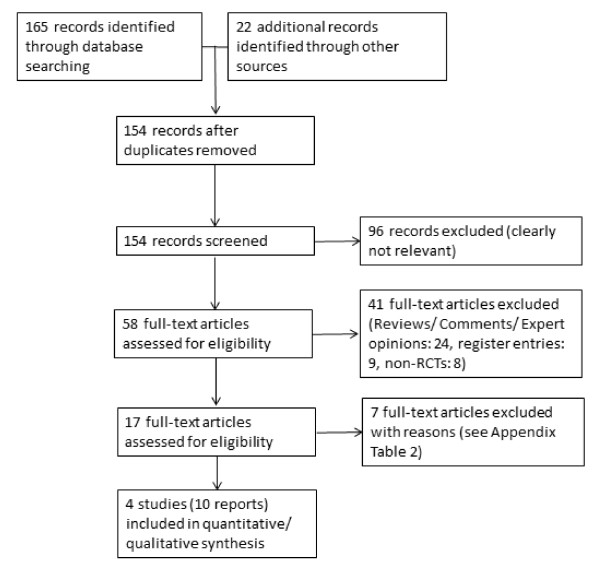
Search flow chart (June 2011).